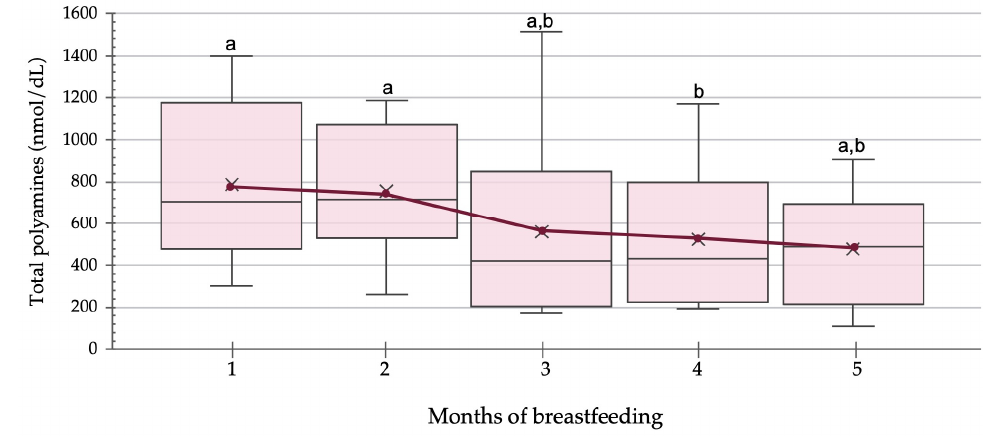
Figure 1. Distribution of total polyamine levels (nmol/dL) in human milk samples ( n = 6) during the first five months of breastfeeding. The bottom and top of each box (interquartile range) are the 25th and 75th percentiles, respectively. The central line represents the median and X represents the mean. Lines extending vertically from the boxes (whiskers) indicate variability outside the interquartile range. The red line represents the evolution of mean polyamine content during the first semester of breastfeeding. The Friedman test with Wilcoxon post hoc were used to compare the total polyamine contents during the breastfeeding process. Different letters indicate statistically significant differ-